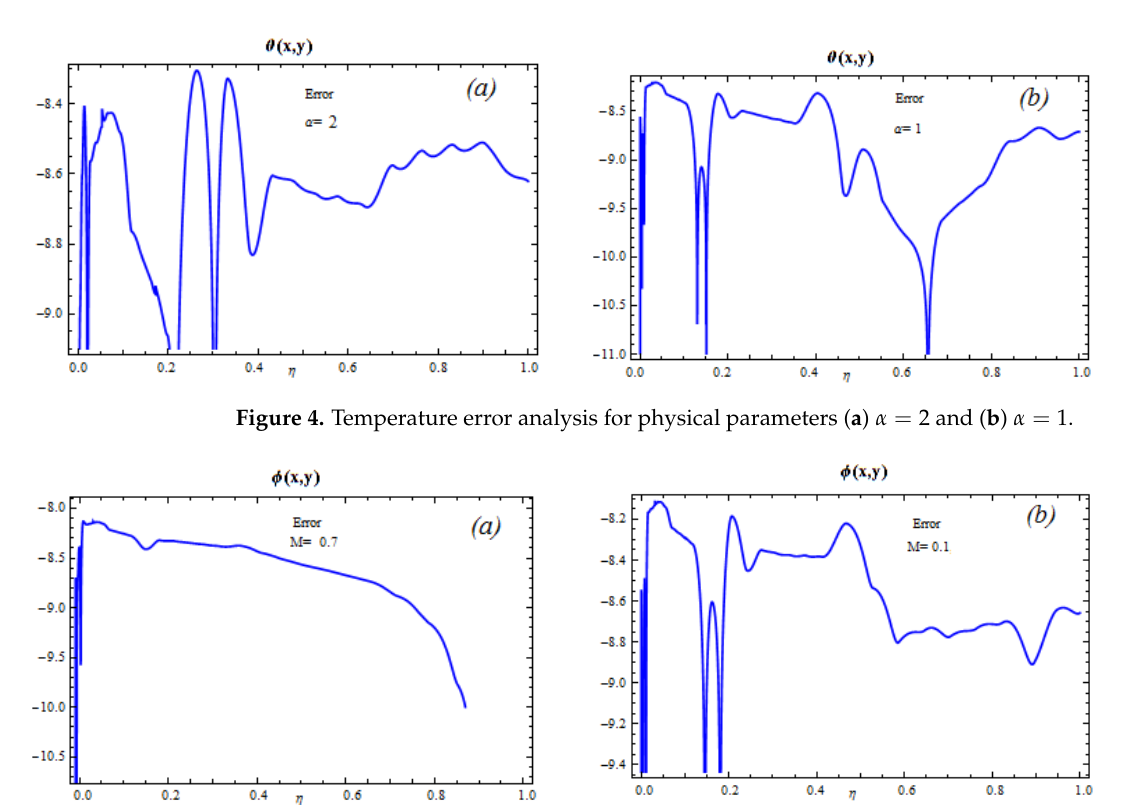
Figure 5. Concentration error analysis for physical parameters ( a ) M = 0.7 and ( b ) M = 0.1.